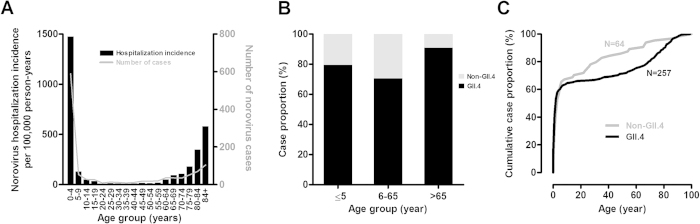
Age distribution of norovirus gastroenteritis.(A) Age-stratified hospitalization incidence and number of cases of norovirus gastroenteritis. (B) Proportion of norovirus genogroup II genotype 4 (GII.4) and non-GII.4 cases in each age group. (C) Age distribution of GII.4 and non-GII.4 cases shown as cumulative case percentage. N, number; yr, year.